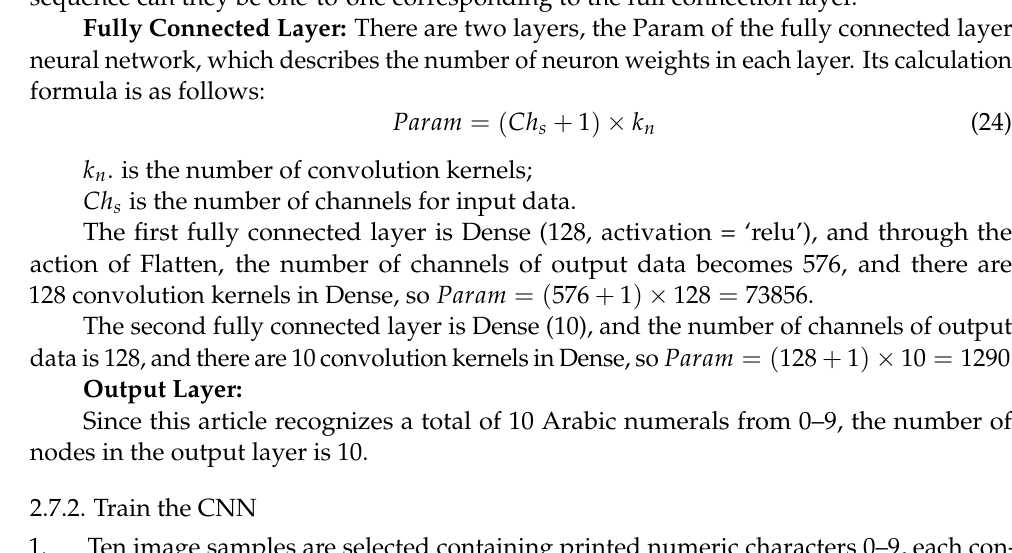
Figure 21. Flowchart and pseudo-code for calculating the number of scale lines. (b) is the portion of the scale extracted from (a) . (c) is the binarized image of (b) . (d) is the pseudo-code of the calcu- lation procedure to obtain the number of scale-lines.